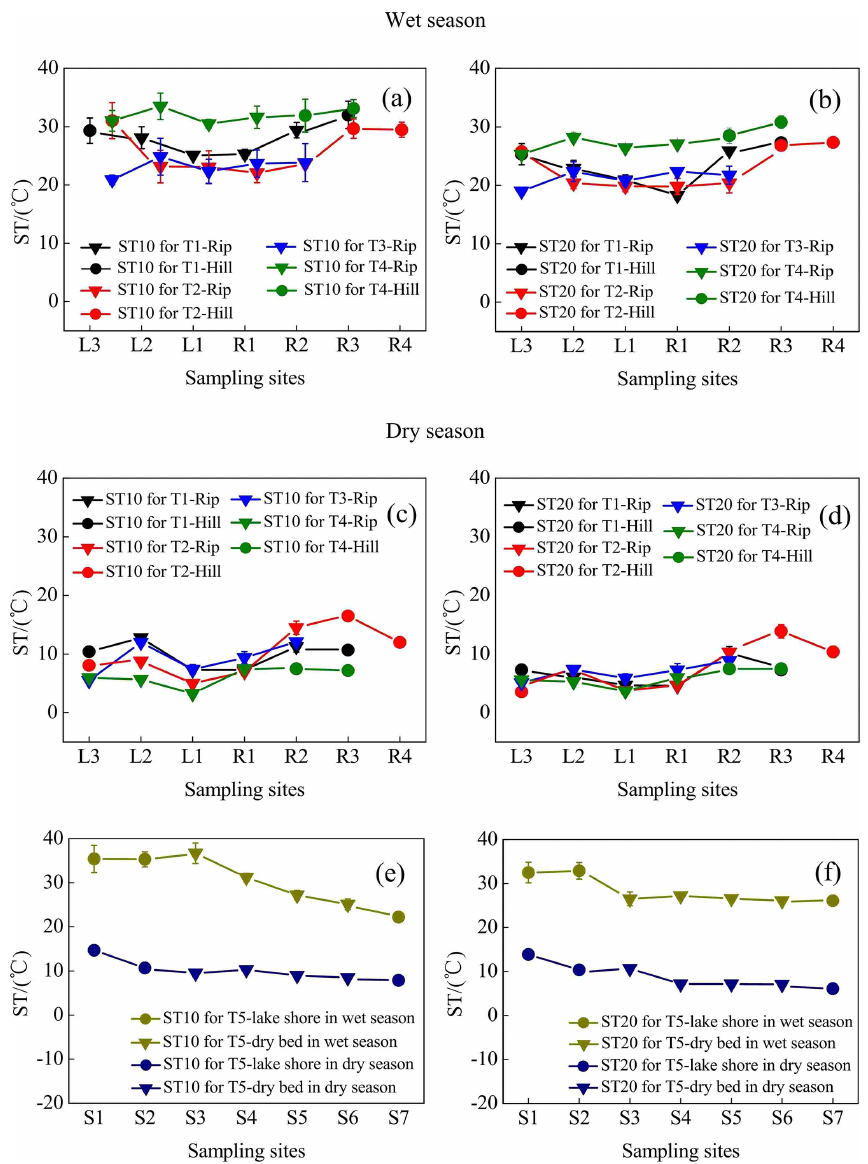
Figure 4. Soil temperatures (STs) at soil depths of 0–10cm (ST10) and 10–20cm (ST20) for transects T1–T5 in the wet and dry seasons. Error bars represent the SD about the mean.